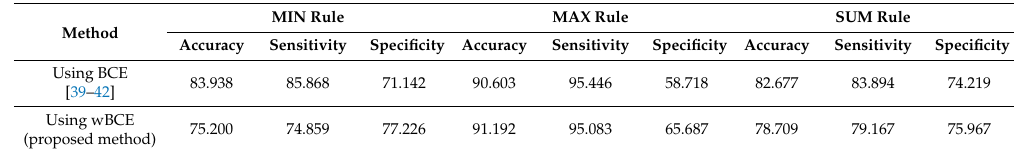
Table 7. Classification performance by combining the two CNN networks using MIN, MAX, and SUM rules (unit: %).